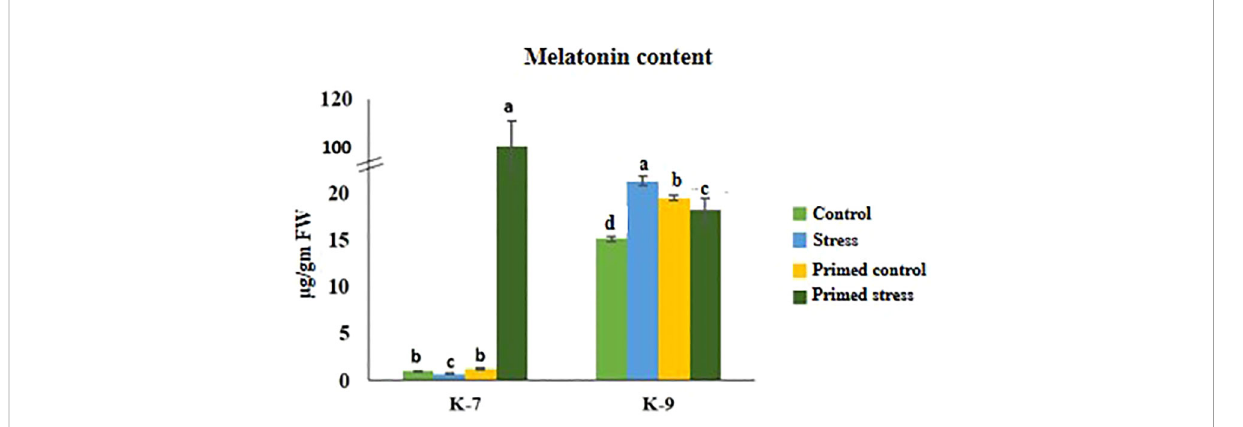
FIGURE 2 Effect of melatonin priming on endogenous melatonin content in drought-sensitive (K-7) and drought-tolerant (K-9) varieties with or without drought stress. Data represents mean values ± SD of minimum 3 independent experiments. Different alphabets within the group represent signi fi cant differences among treatments according to Duncan ’ s multiple range test at P <